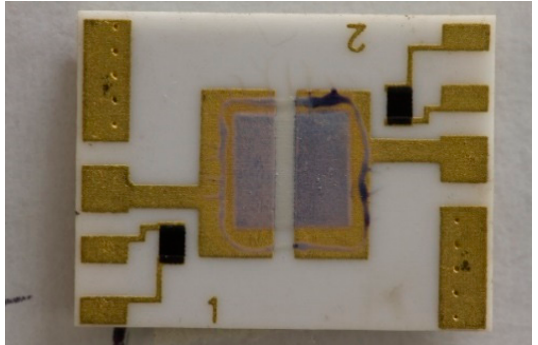
Figure 2. Nc-TiO 2 film deposited on an alumina chip for Thermally Stimulated Currents (TSC) Figure measurements.